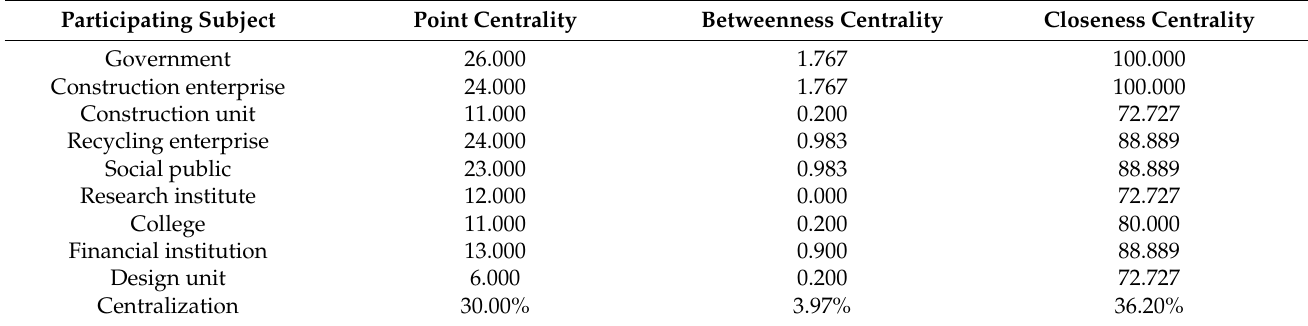
Table 4. Stakeholder centrality